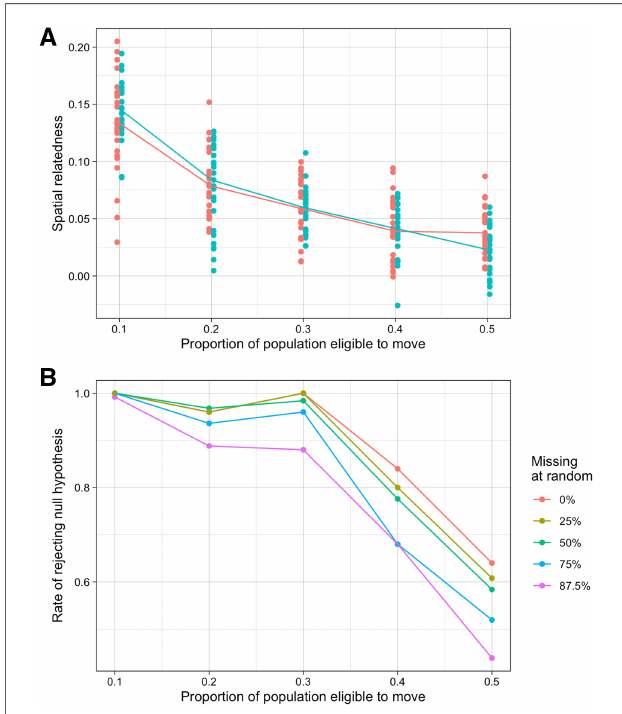
FIGURE 3 Simulated results of spatial relatedness under various mobility and missingness conditions. ( A ) Spatial relatedness across multiple simulations and different proportions of the population moving between locations. Values for each location are shown in different colours and the median is shown by the line. ( B ) Rate that the null hypothesis of no location relatedness structure was rejected at different proportions of random